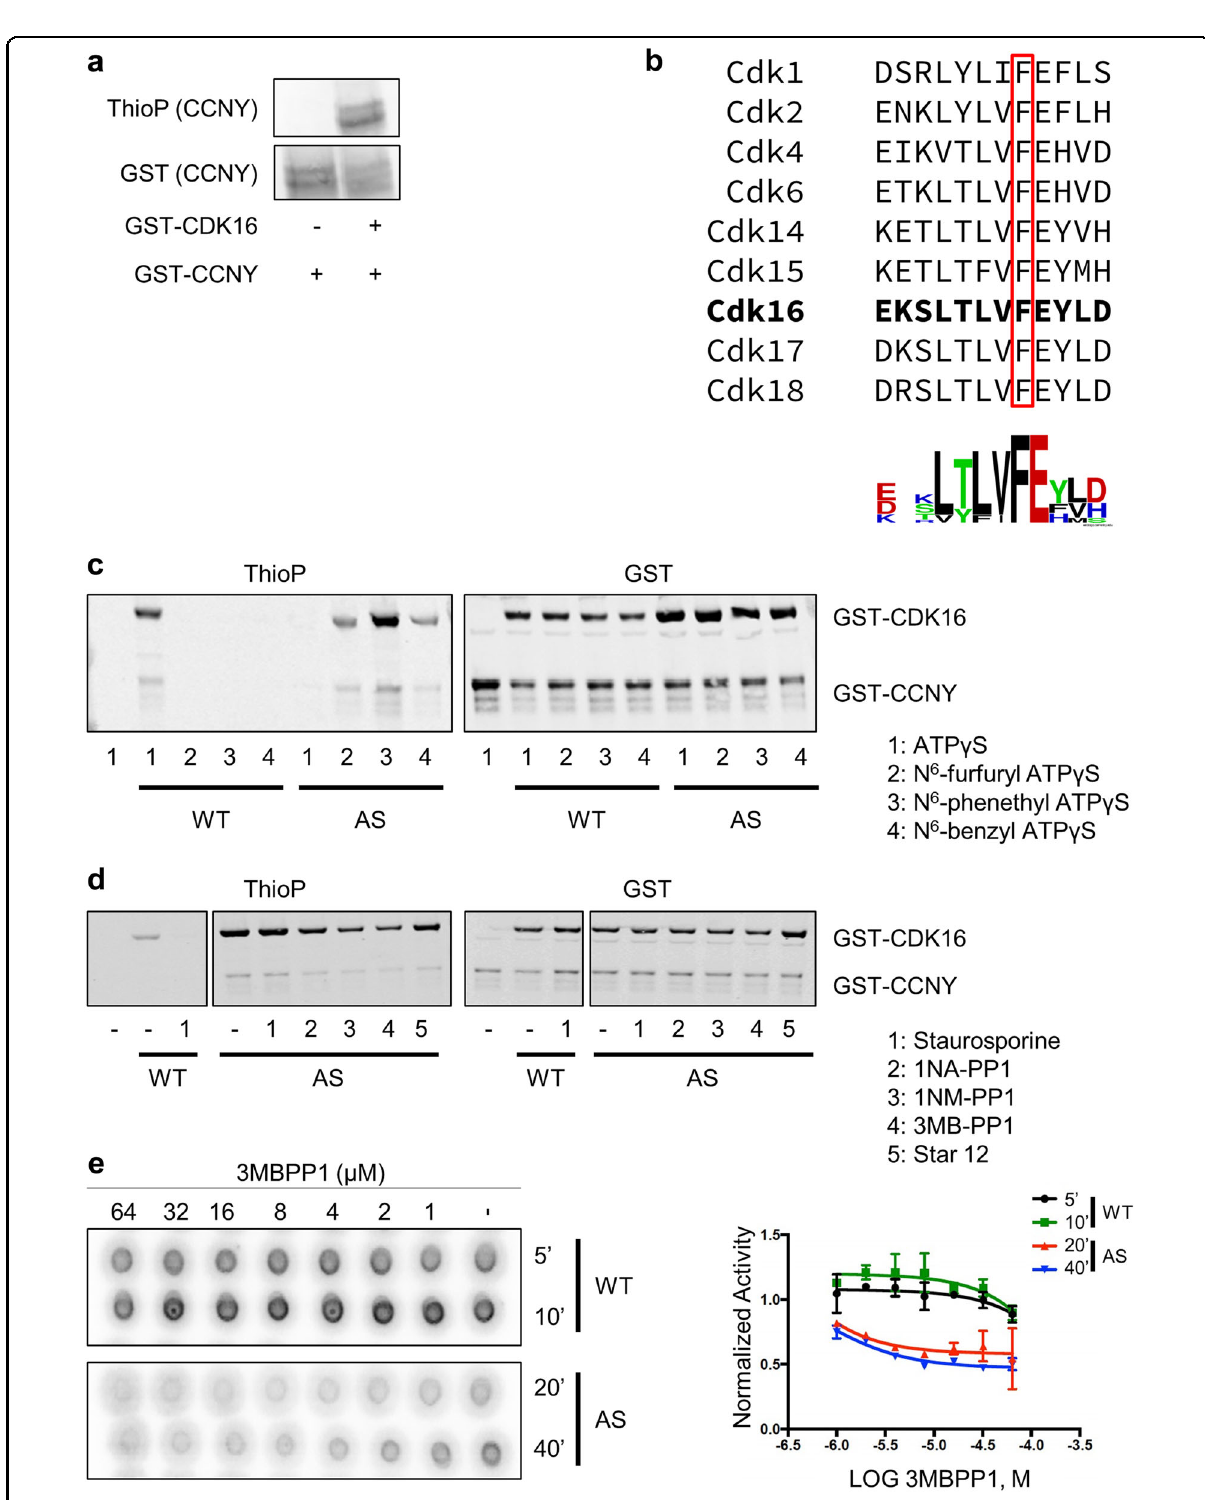
Fig. 1 Generation of an Analog-Sensitive (AS) version of CDK16. a CDK16 phosphorylates CCNY in vitro. ATP γ S was used as a phosphodonor, and thiophosphorylation (ThioP) was evaluated by western blotting. CDK16 and CCNY were puri fi ed from E. coli . b Identi fi cation of the gatekeeper residue in the ATP-binding pocket by sequence alignment with other CDKs. The motif for this conserved sequence was generated using WebLogo. c In vitro kinase assay using WT- or AS-GST-CDK16 with GST-CCNY as a substrate. The indicated N 6 -substituted ATP γ S analog was used as a phosphodonor. d In vitro kinase assay using WT- or AS-GST-CDK16 with ATP γ S or N 6 -Ph-ATP γ S, respectively, in the presence of different inhibitors (1 – 5) to test the ability of these inhibitors to inhibit the AS mutant. e In vitro kinase assay conducted to establish the speci fi c IC 50 of 3MBPP1. WT- or AS-GST-CDK16 was incubated with [ γ - 32 P]-ATP in the presence of different concentrations of 3MBPP1 for the indicated time intervals (in